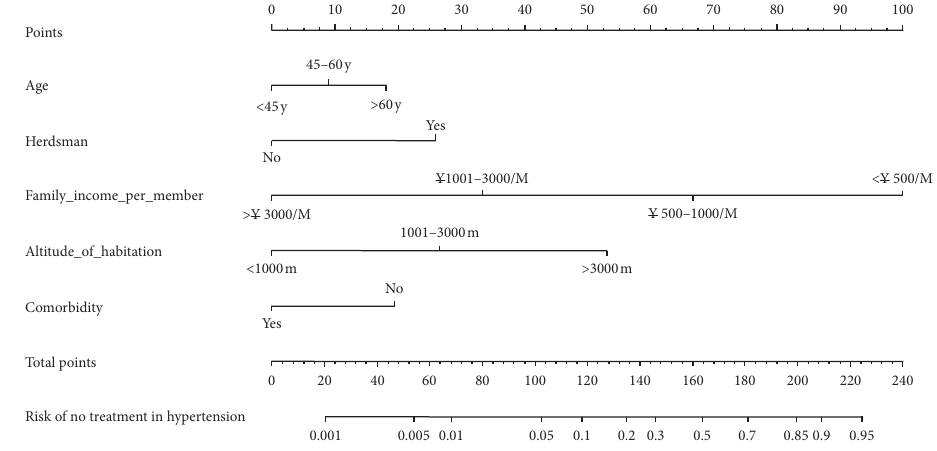
Figure 3: Developed medication nontreatment nomogram.